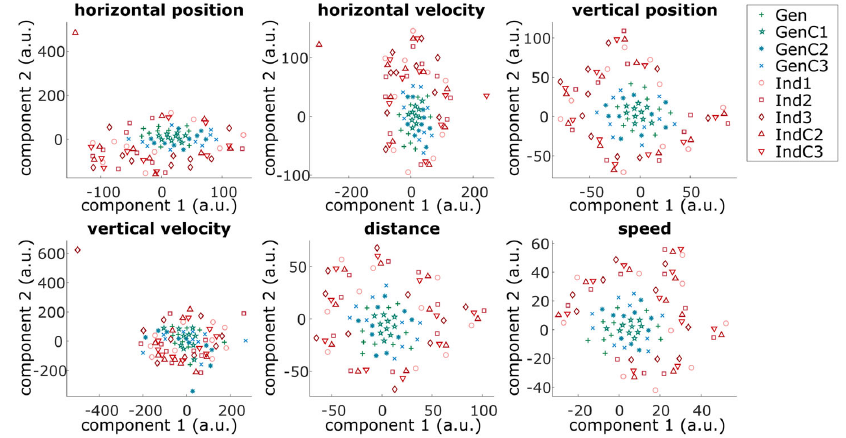
Figure 7. Scatter plots of the reduced dimensionality (via t-SNE [47]) of the decoding patterns of all Figure 7. Sca tt er plots of the reduced dimensionality (via t-SNE [47]) of the decoding pa tt erns of all possible models at di ff erent stages of adaptation. Each point represents participant-speci fi c decod- possible models at different stages of adaptation. Each point represents participant-specific decoding ing pa tt erns. The di ff erent markers represent the di ff erent models. The models from generalized patterns. The different markers represent the different models. The models from generalized and and individual approaches are additionally labeled in green and red, respectively. individual approaches are additionally labeled in green and red,